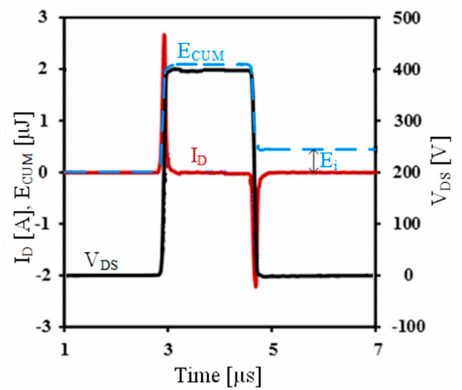
Figure 5. Auriga pulsed I–V tests: I D and V DS waveforms. Procedure to obtain the cumulative energy and the value of E i to propose the new figure of merit